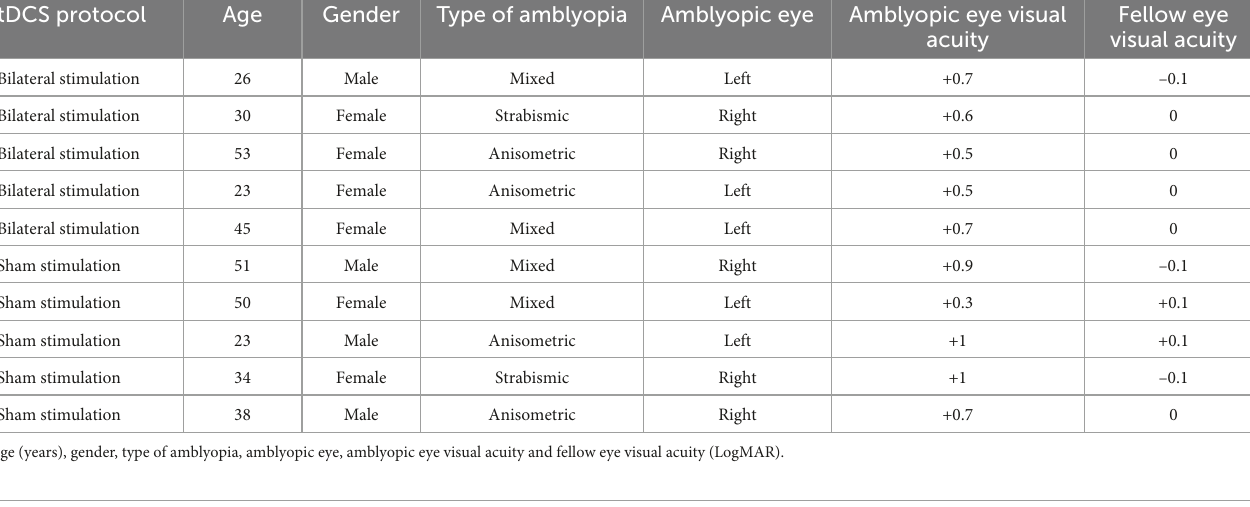
TABLE 1 Characteristics of the participants.